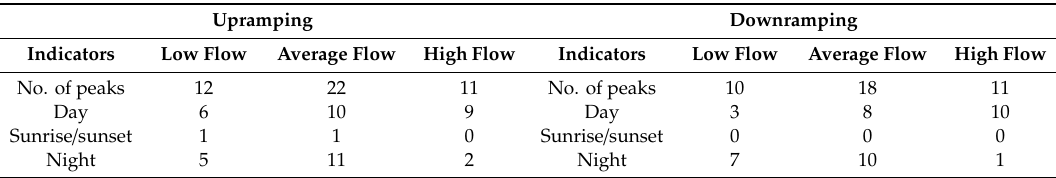
Table 3. Frequency of hydropeaking events during 24 h period depending on river channel flow conditions in Nemunas River at Kaunas HPP GS (0.0 km). Low, average and high river channel flow conditions in 2015, 2016, and 1988, respectively. Upramping